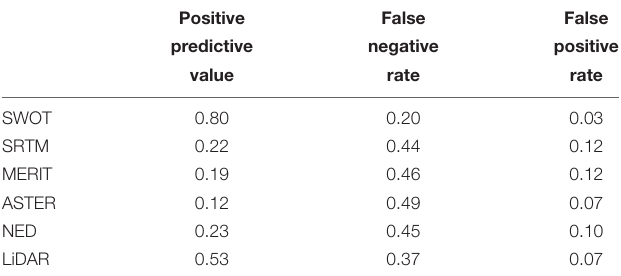
TABLE 4 | Classification statistics for the relative steepness threshold. Positive False False predictive negative